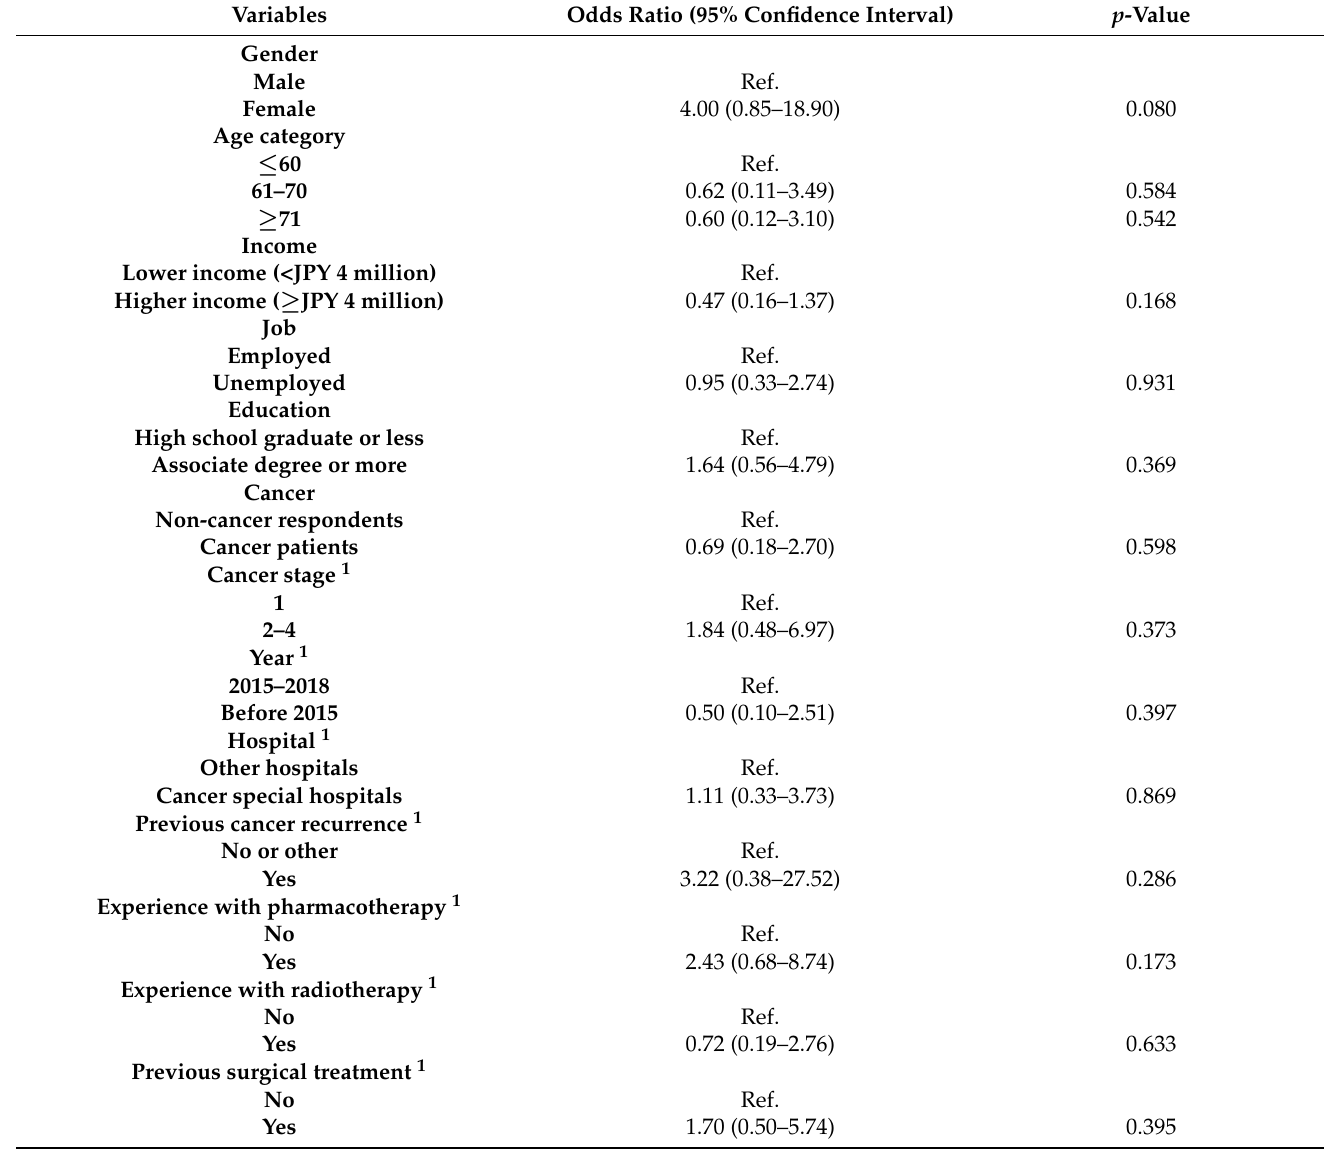
Table 3. Logistic regression analysis of respondents’ awareness of physician–Pharma